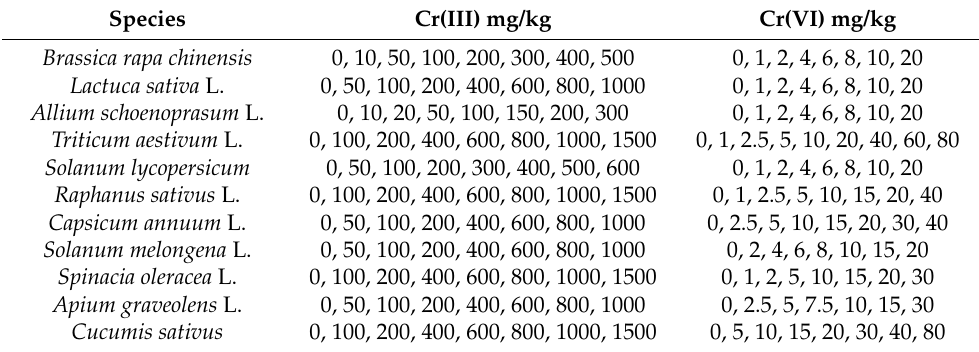
Table 2. Initial concentration of Cr(III) and Cr(VI) for test